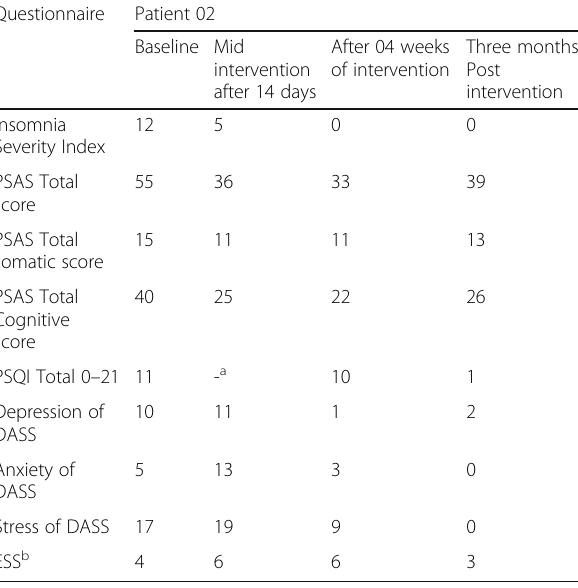
Table 2 Questionnaires of patient 02 during the intervention and at follow ups